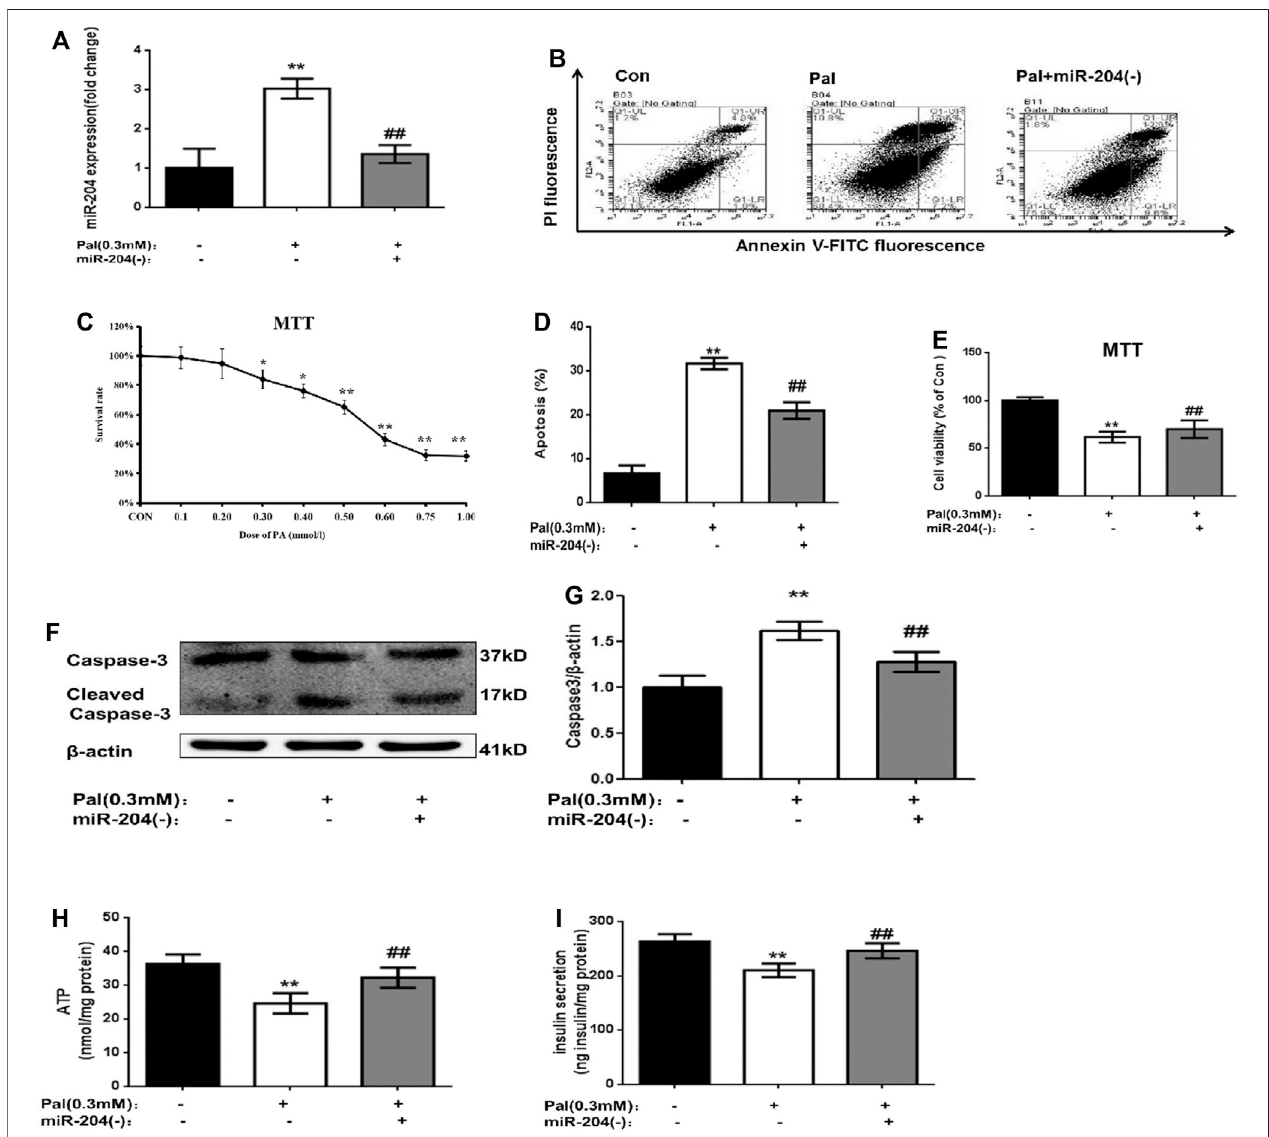
FIGURE 2 | Palmitate (PA) induce the apoptosis in MIN6 cells and miR-204 silencing can mitigate this injury. After treated with PA for 24 h in normal cells (A) miR- 204 expression was measured by RT-PCR. Con: control group, Pal:PA-treated MIN6 group, Pal + miR-204 ( − ):PA-treated + miR-204 ( − ) MIN6 group (B – D) The apoptosis was observed and analyzed by fl ow cytometry (C) The doses of PA-induced cytotoxicity in MIN6 cells were assessed by MTT assay. (E) The in fl uence of PA- induced cytotoxicity and the mediation of miR-204 silencing were assessed by MTT assay. (F, G) The protein was extracted from cells and caspase3 were measuredby Western Blot (H)ATPconcentration inthe supernatantof MIN6cells wasdetected. (I) Basal insulin release and contentwere measured in MIN6. Datawas expressed as means ± SEM ( n (cid:1) 6). * p < 0.05,** p < 0.01, compared with control group; ## p < 0.01, compared with PA group.